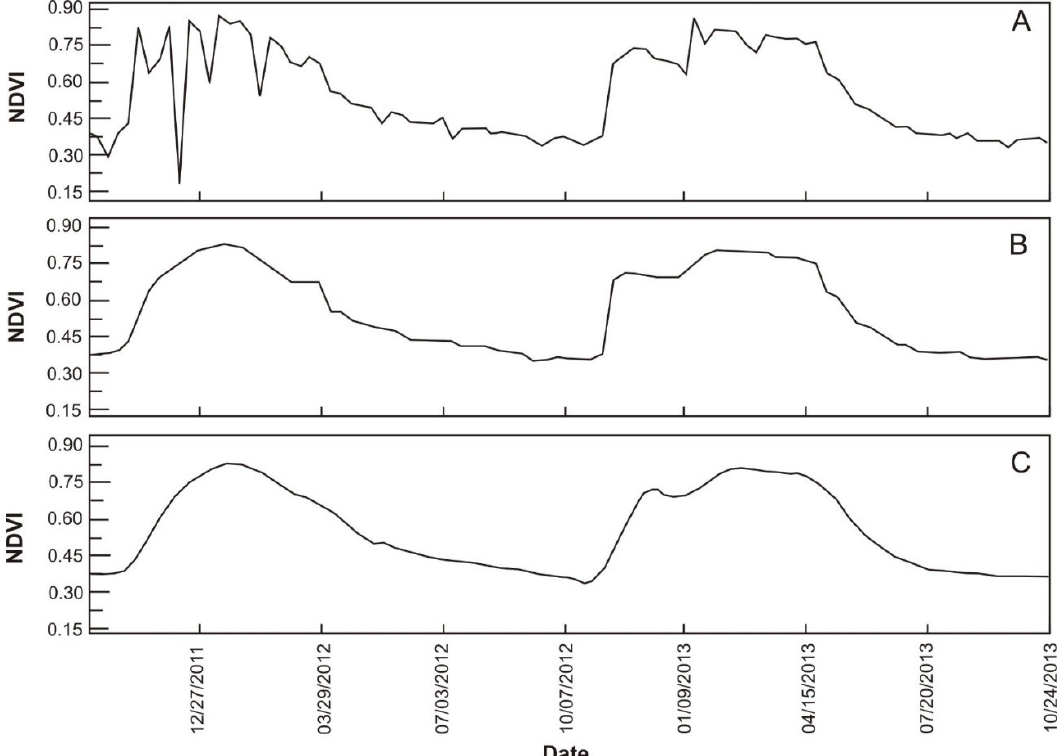
Figure 5. MODIS-NDVI time series, ( A ) original data with noise, ( B ) time profile softened by the median filter, and ( C ) refined by the